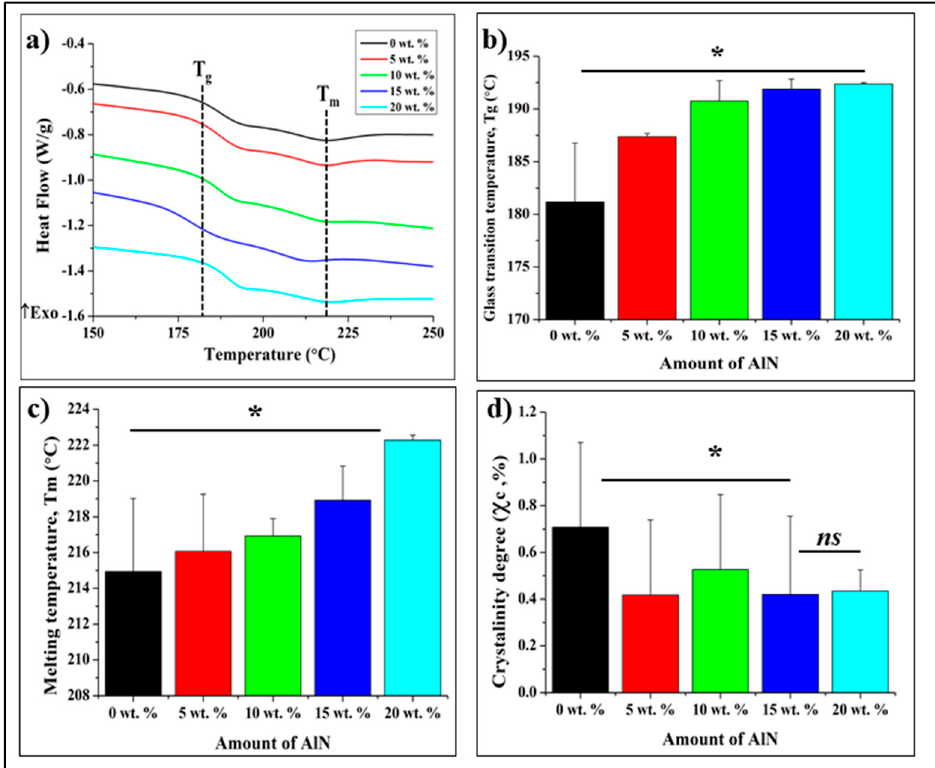
Figure 8. DSC curves for the CA/AlN composites ( a ), 2nd heating curve ( b ), Glass transition temperature, Tg, ( c ), Melting temperature and ( d ), crystallinity degree. * = p < 0.05, ns = p > 0.05